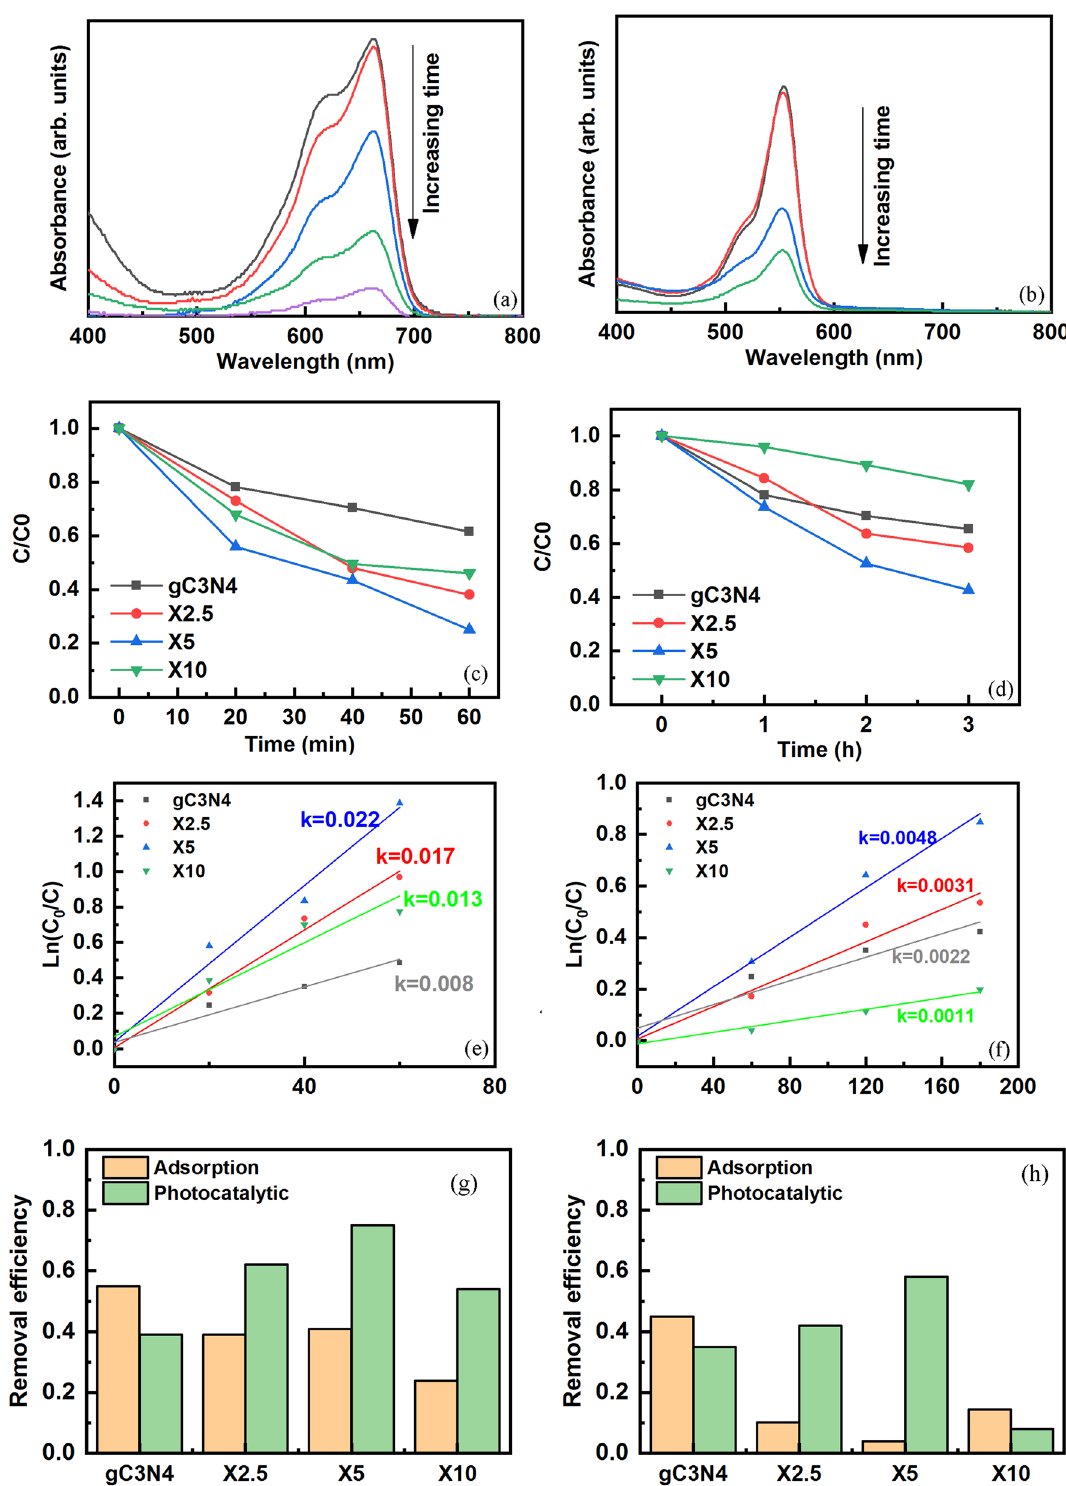
Figure 4. UV–Vis spectra of ( a ) MB and ( b ) RhB dye in the presence of the X5 composite sample, the relative concentration of ( c ) MB and ( d ) RhB dyes versus illumination time, Ln(C0/C) versus time for ( e ) MB and ( f ) RhB dyes, and removal efficiency of ( g ) MB and ( h ) RhB dyes by various